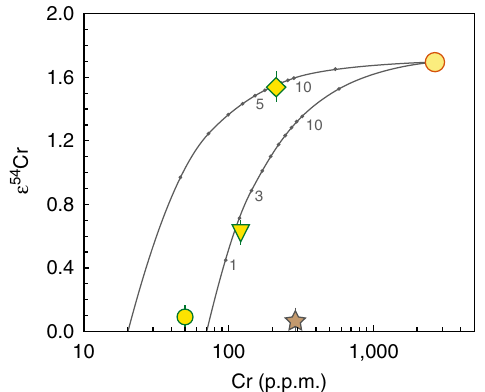
Fig. 5 Simple binary mixing model for impact glasses from Zhamanshin with CI chondrite impactor. CI chondrite with 2650 p.p.m. Cr and ε 54 Cr = 1.7 ( yellow circle with a red rim ; see main text for data sources) was mixed with different target materials, a Cr-poor (20 p.p.m.) composition for irghizite IR-8 ( diamond ) and intermediate-Cr (70 p.p.m.) composition for composite splash-form IR-7 ( reversed triangle ), re fl ecting their different sources 28 . The numbers along the calculated mixing lines indicate a proportion of the impactor matter in the mixture. The 54 Cr results are identical to 53 Cr results (not shown), supporting the robust nature of the mixing process. The nil effects for moldavite SBM-88 ( yellow circle with a green rim ) and terrestrial standard BHVO-2 (star) are documented. The errors for ε 54 Cr values are 2 s.e. (see Table 2), the errors for Cr concentrations (1 – 3% RSD) 28 are smaller than the corresponding